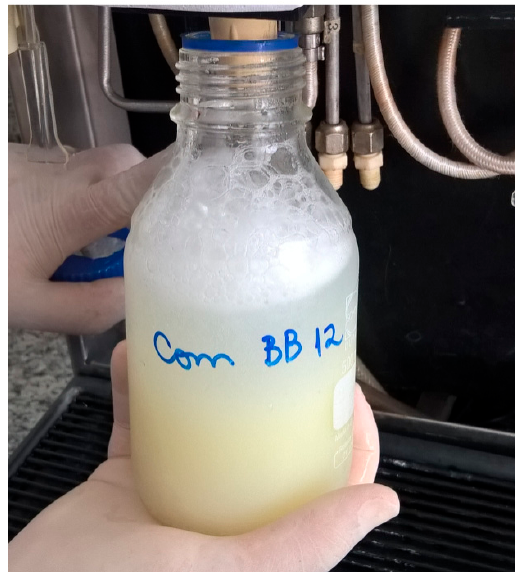
Figure 3. Carbonation step of the probiotic beverage.